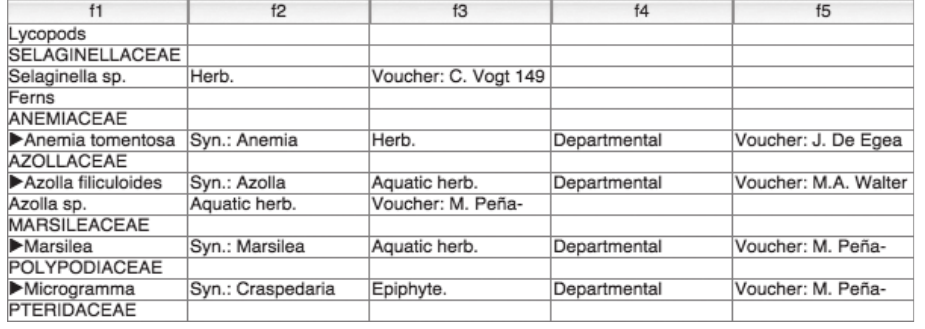
Figure 2. Taxon records imported into a database.